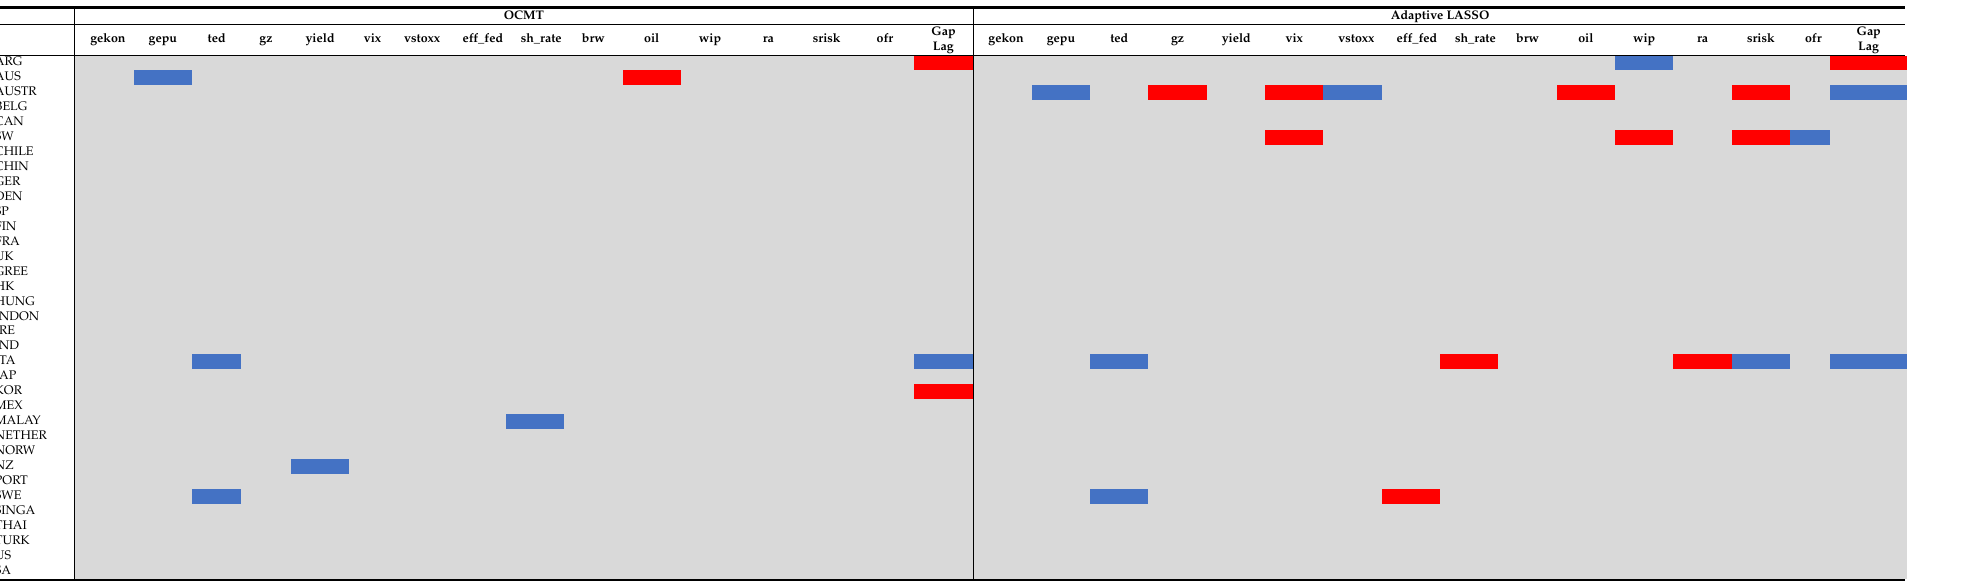
Table 2. Global determinants of credit-to-GDP gaps in